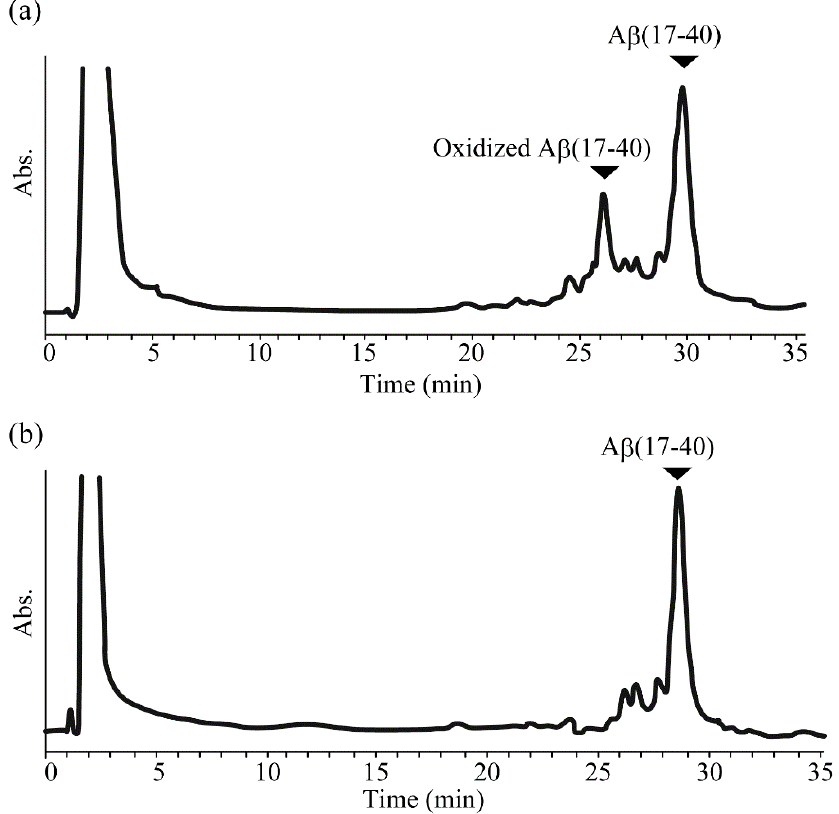
Figure 3. ( a ) HPLC chart of the cleaved A β (17-40) from HMBA resin without the reduction process. ( b ) HPLC chart of the cleaved A β (17-40) from HMBA resin with the reduction process not using mercaptoacetic acid. The peaks were characterized by MALDI-TOF MS: the oxidized A β (17-40), m / z 2409.9 ((M + H) + calcd. 2409.7); A β (17-40), m / z 2393.6 ((M + H) + calcd. 2393.7).